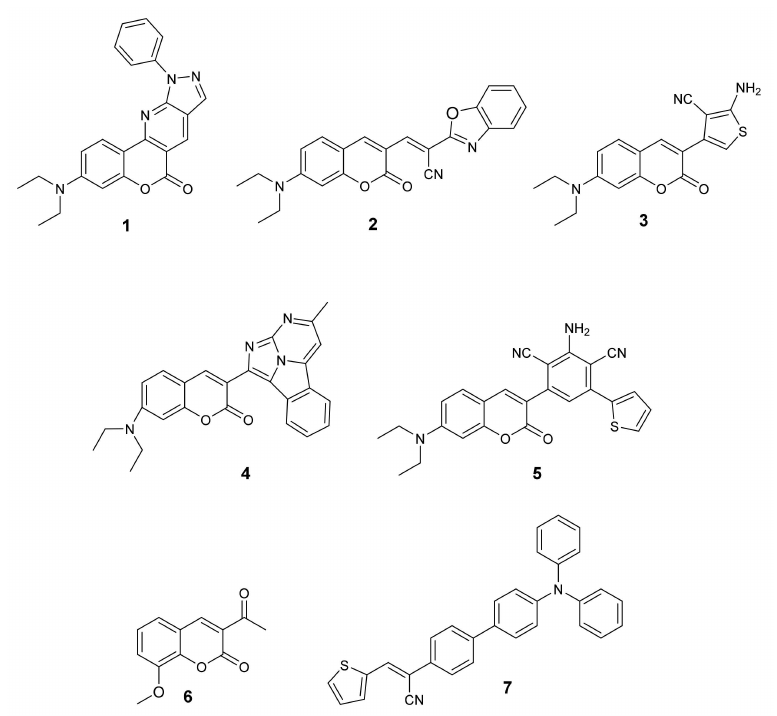
Figure 4. Reported coumarin compounds with photophysical properties in solution, used for com- parison purposes